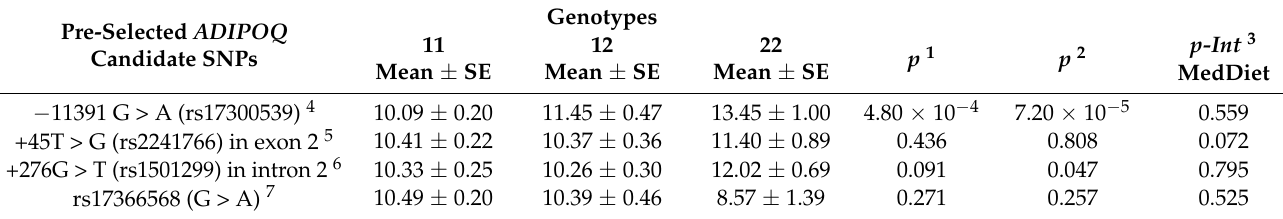
Multivariable adjusted models and gene-diet interactions with adherence to the Mediterranean diet. 11, 12 and 22 indicate the three genotypes for each SNP: 1 major allele, 2 minor alleles. Mean adiponectin concentrations are expressed in µ g/mL. 1 : p -value obtained in the unadjusted general linear additive model. 2 : p -value obtained in the general linear additive model adjusted for sex, age, diabetes, BMI, physical activity, smoking and adherence to the Mediterranean diet. 3 : p -value for the interaction term between the corresponding SNP and adherence to the Mediterranean diet in the multivariable model 2. 4 : Genotype prevalence was 78.4% GG; 19.6% GA; and 2.0% AA ( n = 951). 5 : Genotype prevalence was 67.2% TT; 28.9% TG; and 3.9% GG ( n = 954). 6 : Genotype prevalence was 51.9% GG; 39.2% GT; and 8.9%